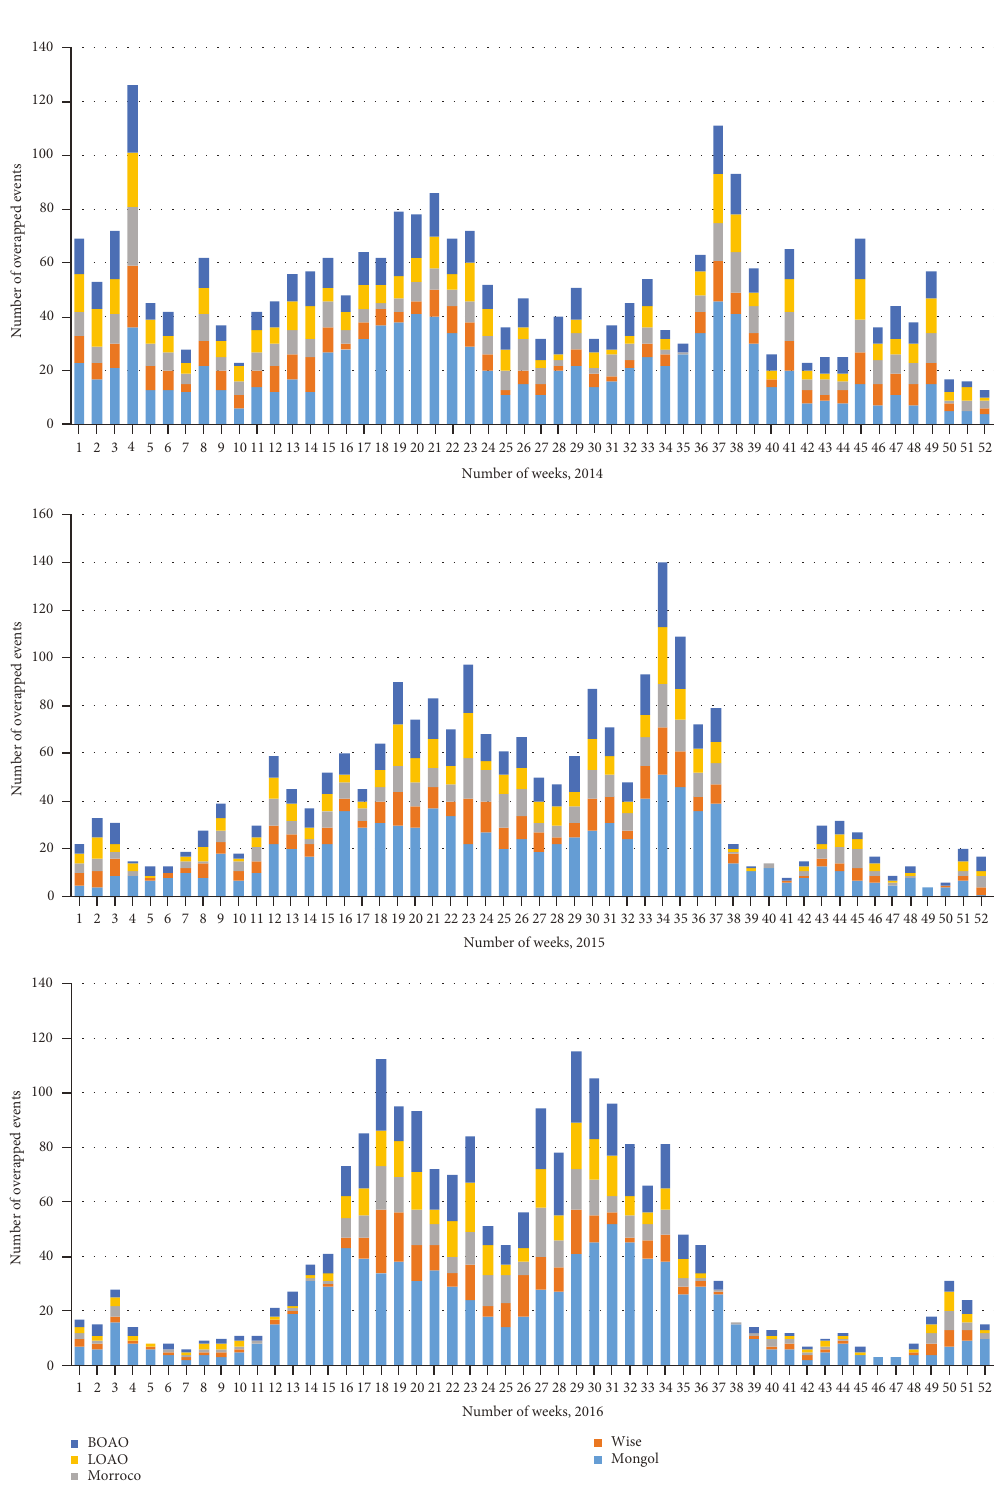
Figure 4: Weekly variation of number of optical observation overlapped events for 11 LEO observation targets at the fi ve OWL-Net stations from 2014 to